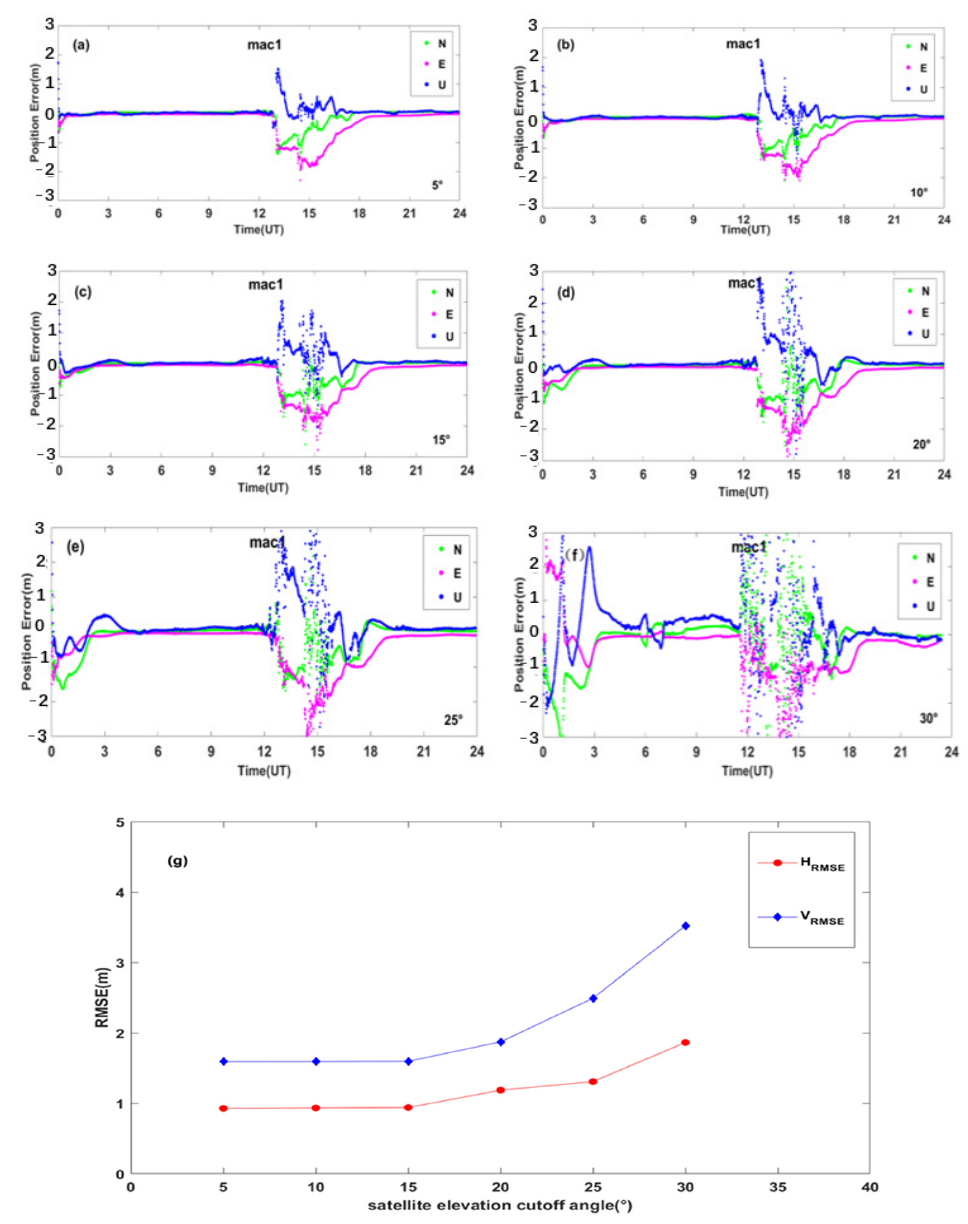
Figure 17. ( a – f ) Positioning error at station mac1 for different satellite elevation cutoff angles; ( g ) the dependence of PPP positioning errors on different elevation cutoff angles.